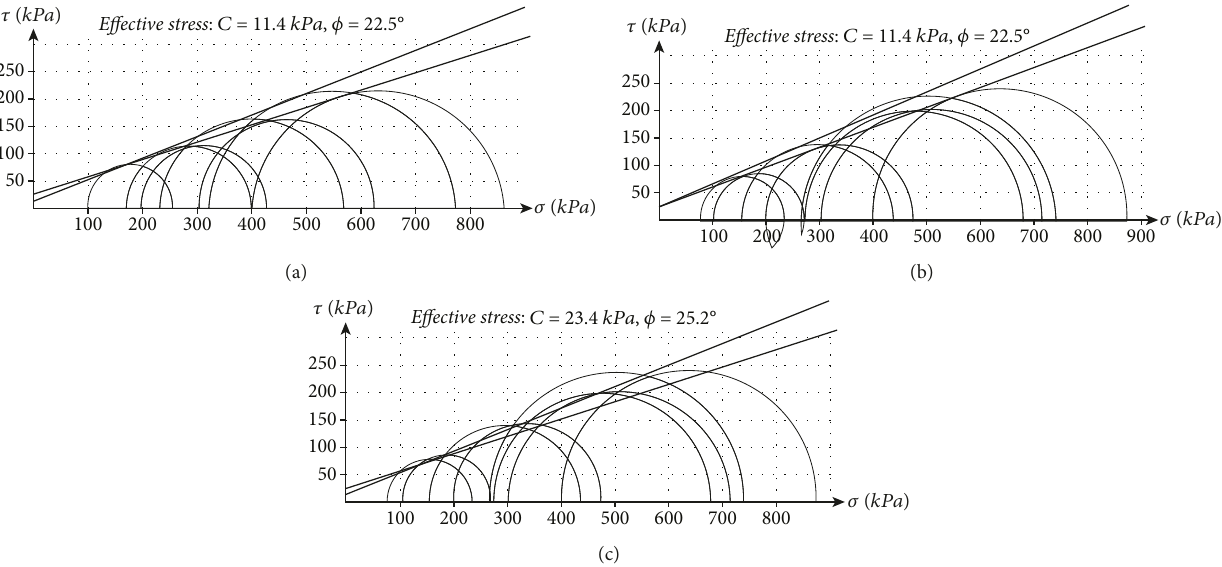
Figure 11: Tests fi tting curve of soil samples for triaxial shear test (group a, b, and c). Table 2: Results of triaxial consolidation undrained shear tests of soil